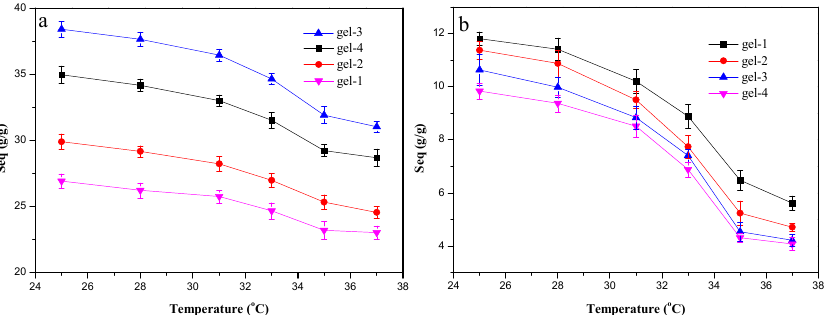
Figure 1. The influences of the temperature (25–37 °C) and pH (7.4 ( a ) and 1.5 ( b )) on the swelling ratio (S eq ) of MAHX-gels.